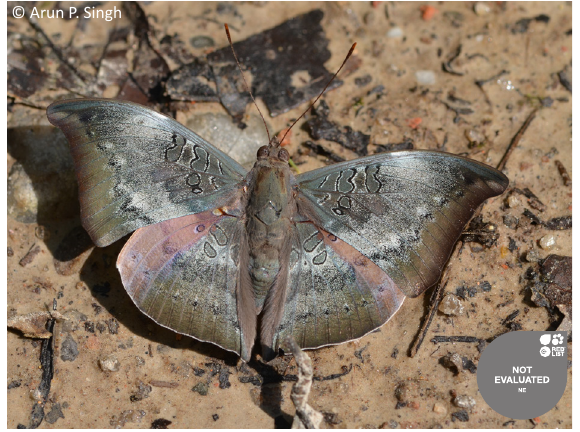
Image 8. Grey Baron Euthalia anosia (male) Image 9. Sylhet Oakblue Arhopala silhetensis (underside)